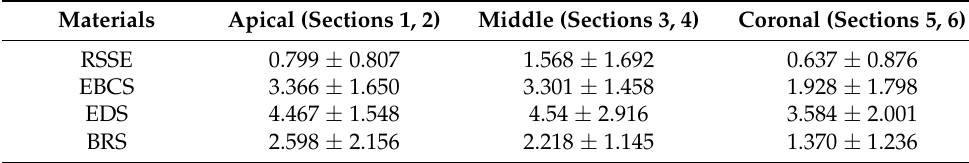
Table 4. Mean and standard deviation of push-out strength values (MPa) within the apical, middle, and coronal thirds.